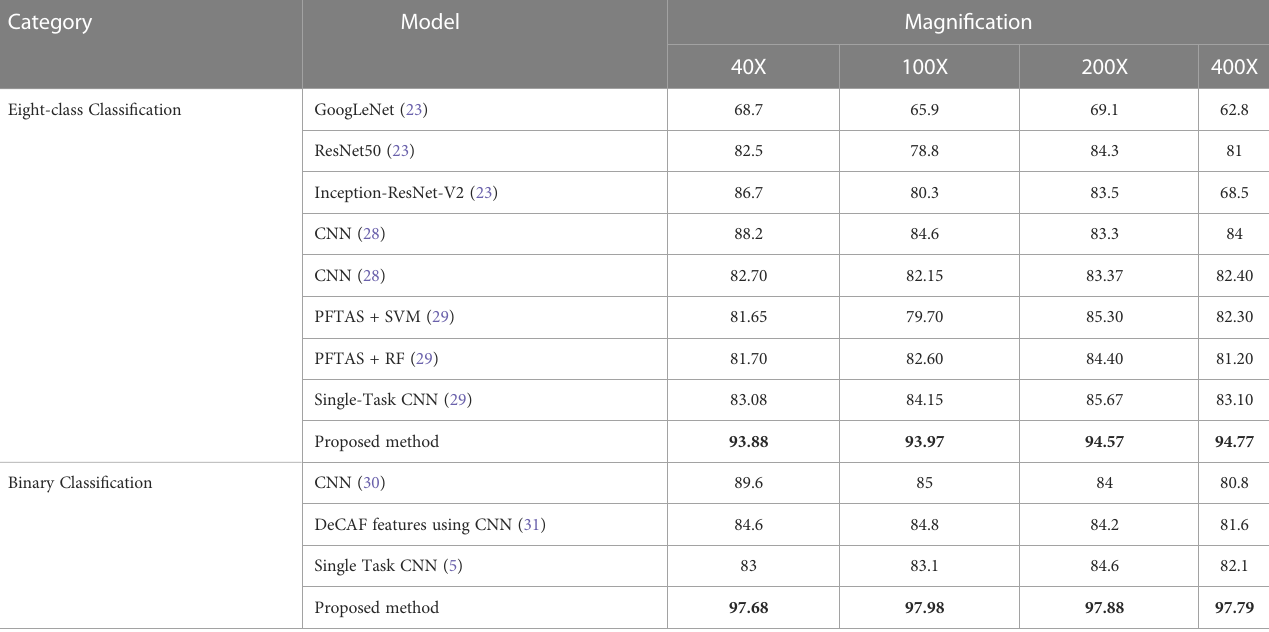
The bold values indicate the highest accuracy under the same TABLE 11 Confusion matrix of three-class classi fi cation results and values of evaluation metrics. Sen, sensitivity; Spe, speci fi city; PPR, positive prediction rate; NPR, negative prediction rate. Ground Truth Classi fi cation Result Sen (%) Malignant Benign Normal Malignant